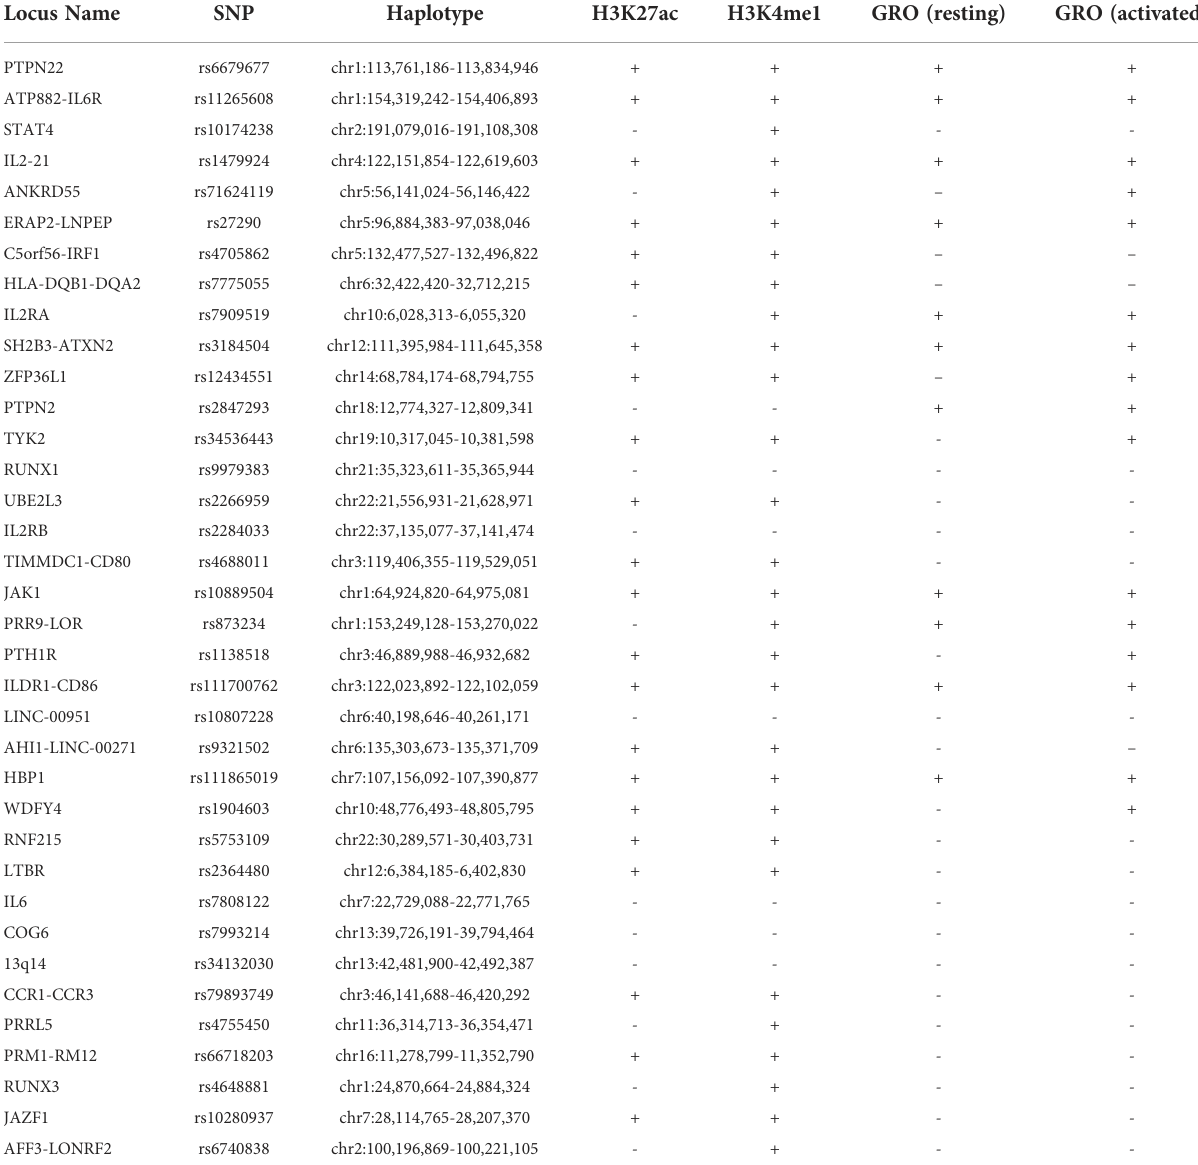
“ + ” indicates the presence of the corresponding histone maker, “ - “ indicates the absence. SNP – single nucleotide polymorphism, rs – reference SNP cluster ID, chr – chromosome, GRO-